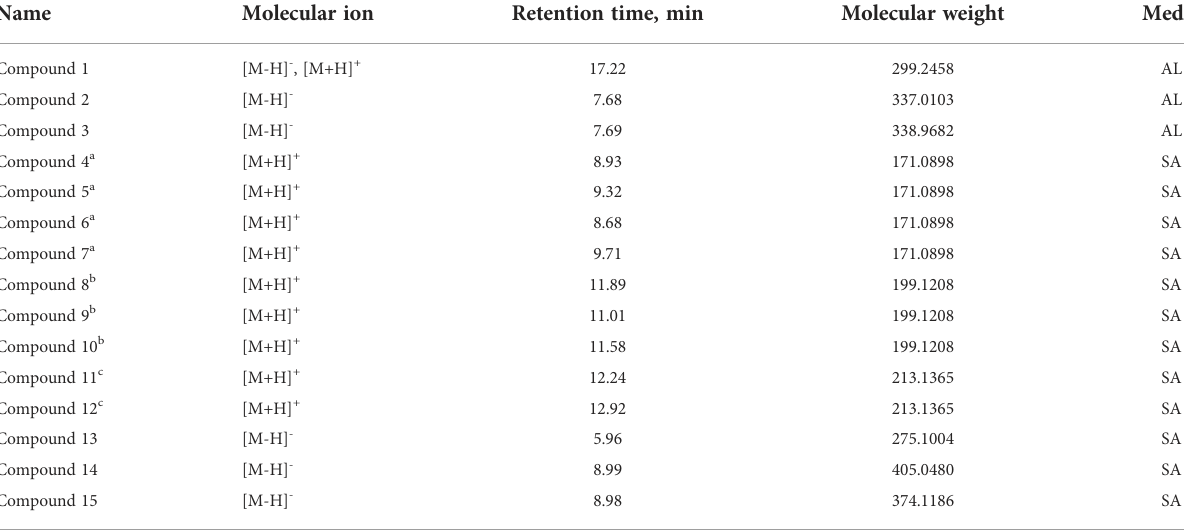
TABLE 6 Identi fi ed metabolites with the potential to inhibit of A. tumefaciens